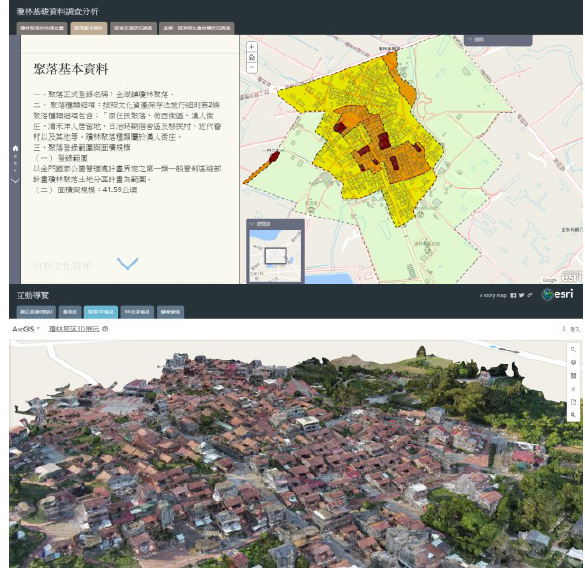
Figure 4. A result of integrated presentation of